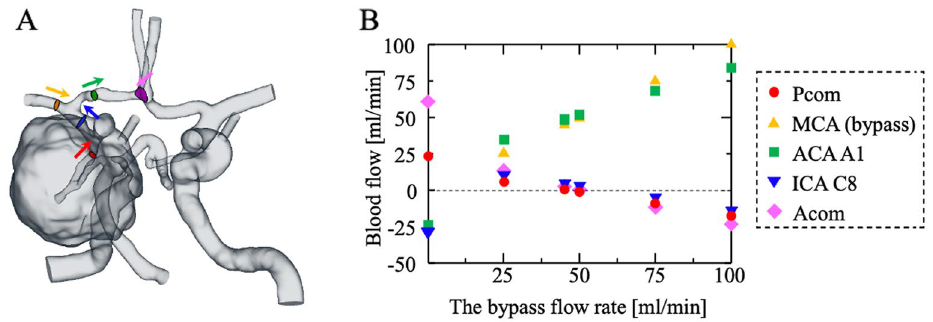
Figure 2. (a) The definition of cross-sections where blood flow was obtained. (b) Plot of the blood flows in various blood vessels against the bypass flow rates.